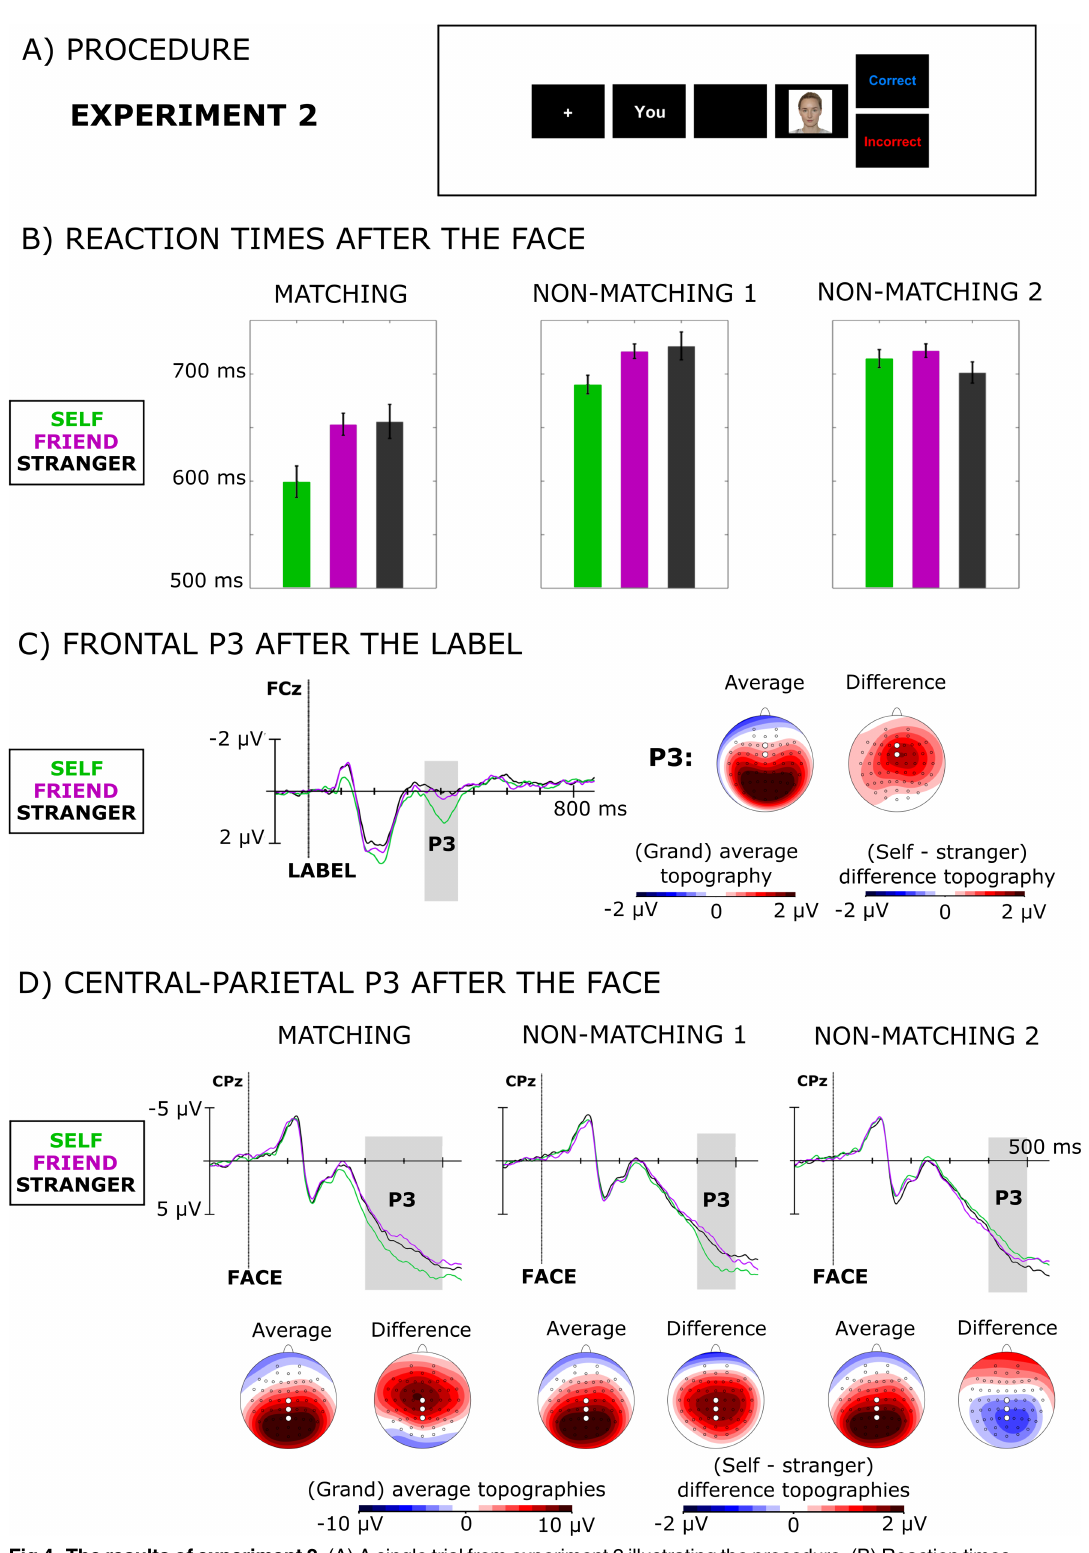
Fig 4. The results of experiment 2. (A) A single trial from experiment 2 illustratingthe procedure. (B) Reactiontimes separately for (from left to right) matching, non-matching 1 (NM1), and non-matching 2 (NM2) trials (see Fig 2 for explanation